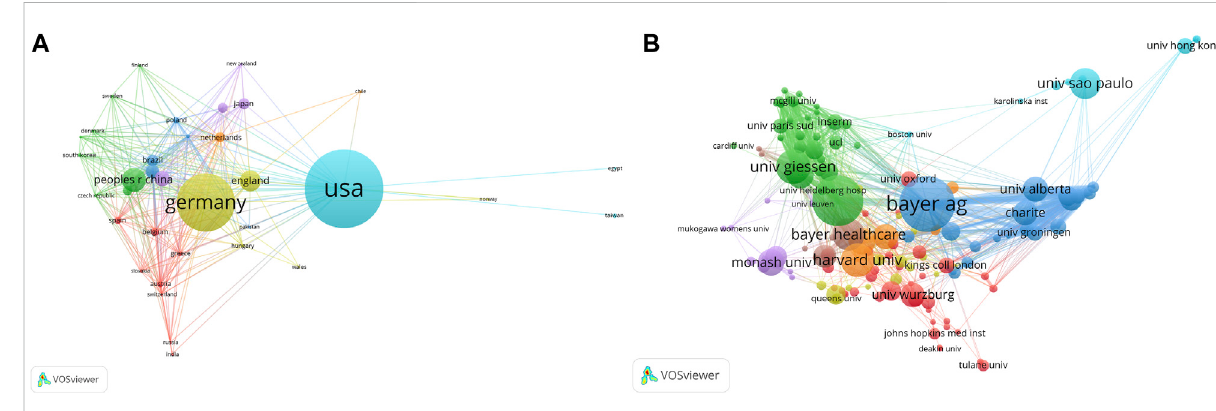
FIGURE 2 VOSviewer network visualization map of country/regions and institutions involved in sGC situmators in cardiovascular research. (A) Collaboration analysis of countries/regions (B) Collaboration analysis of institutions.